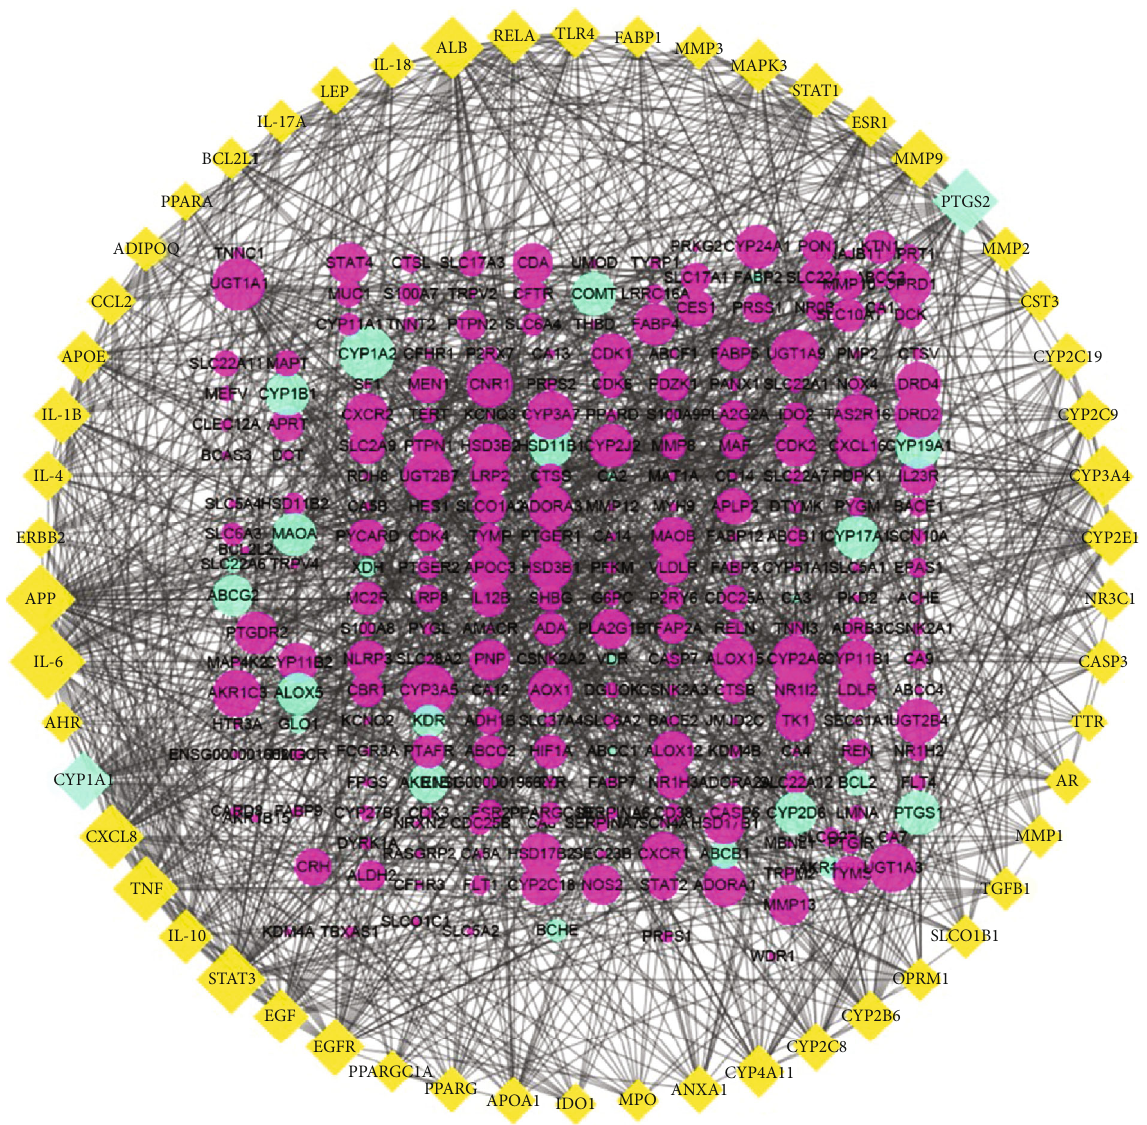
Figure 3: The protein-protein interaction network. Yellow diamonds and red circles represented the targets of compounds and disease, respectively. Green diamonds and green circles indicated 28 common targets. The size of circles and diamonds indicated node degree